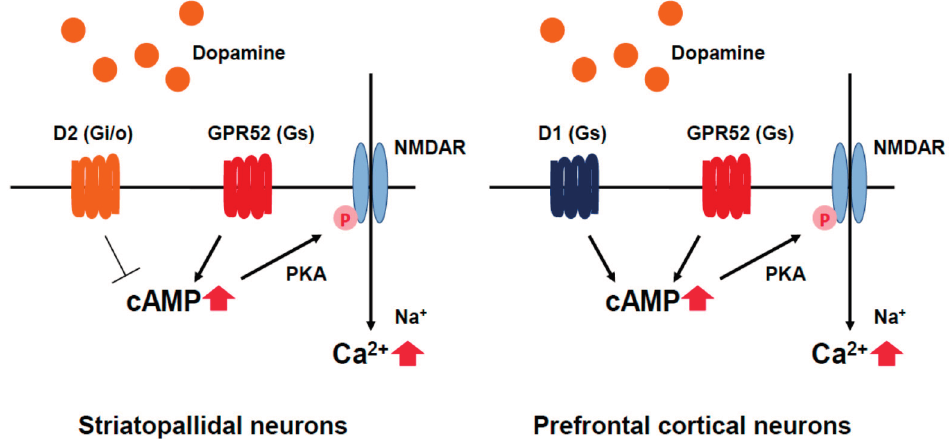
Figure 2. Proposed GPR52 signal transduction. GPR52 activation counteracts Gi/o-coupled D2 receptors in striatopallidal neurons ( left ); and potentiates NMDA activity through phosphorylation of the NMDA receptor via cAMP/PKA, as seen in D1 receptor-NMDA signal transduction ( right